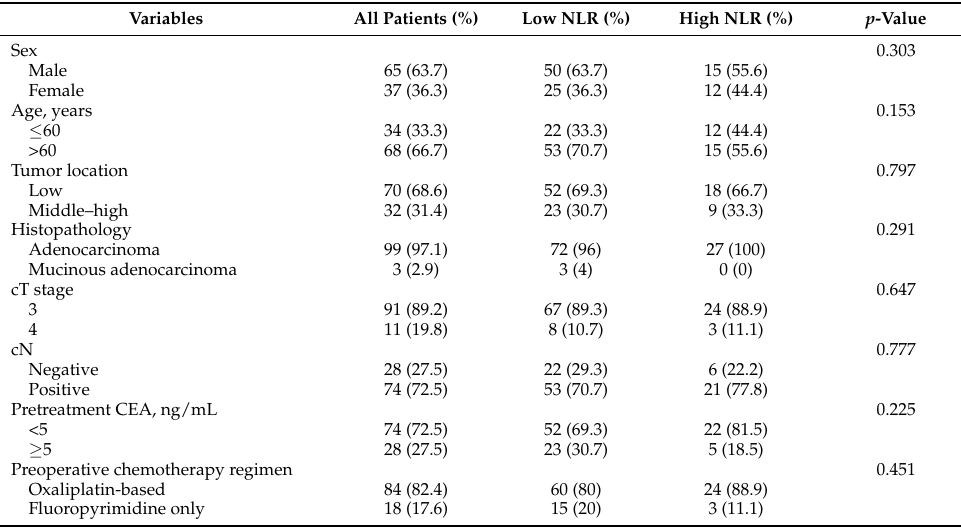
Figure 1. Flow chart of the study population selection. Table 1. Patient characteristics of pathological complete response patients ( n =